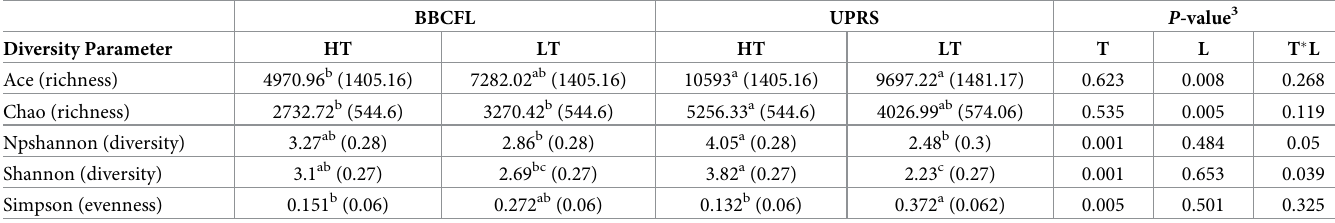
Table 3. Fungal species richness and diversity estimators for fecal microbial communities across location 1 and tolerance groups 2